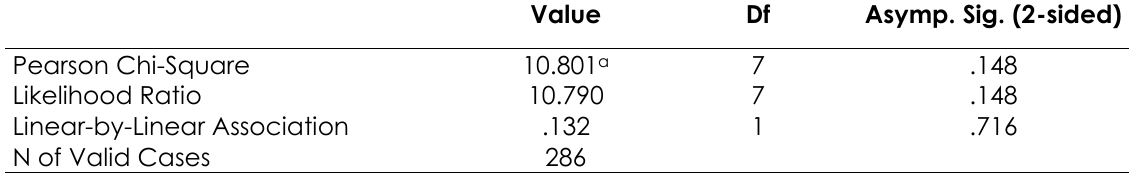
Chi-Square Tests of E-Learning and Technical System Quality